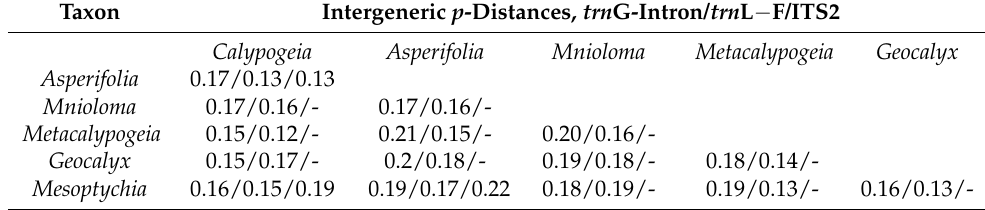
Table 2. Intergeneric p -distances over sequence pairs between groups. The number of base differences per site from averaging over all sequence pairs between groups is shown.